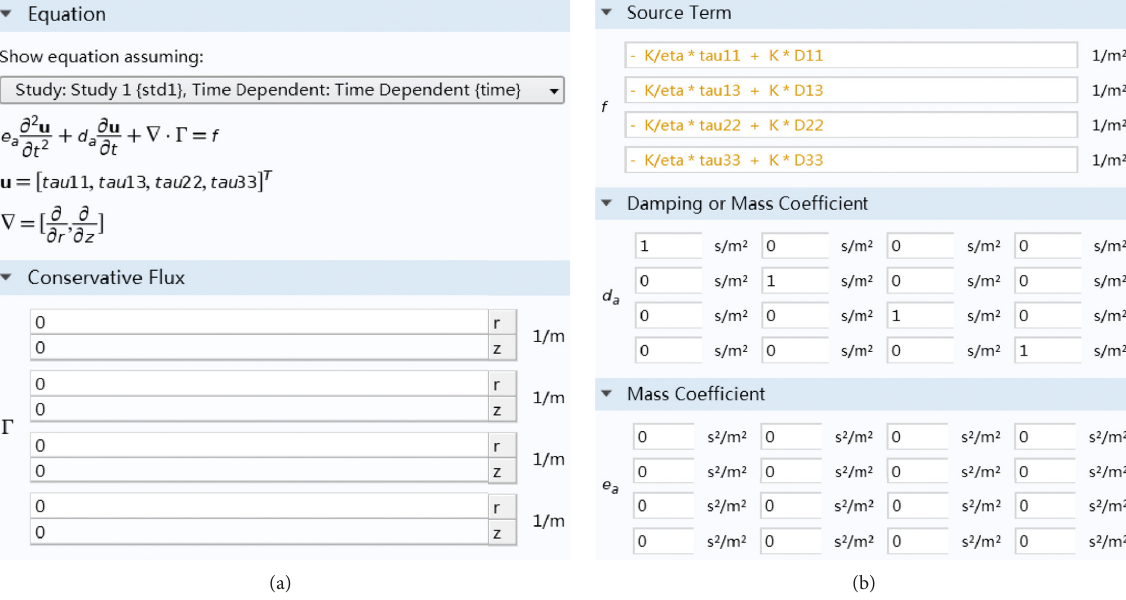
Figure 4: Input of constitutive equation in COMSOL. (a) Conservative flux term. (b) Source term, damping coefficient matrix, and mass coefficient matrix.